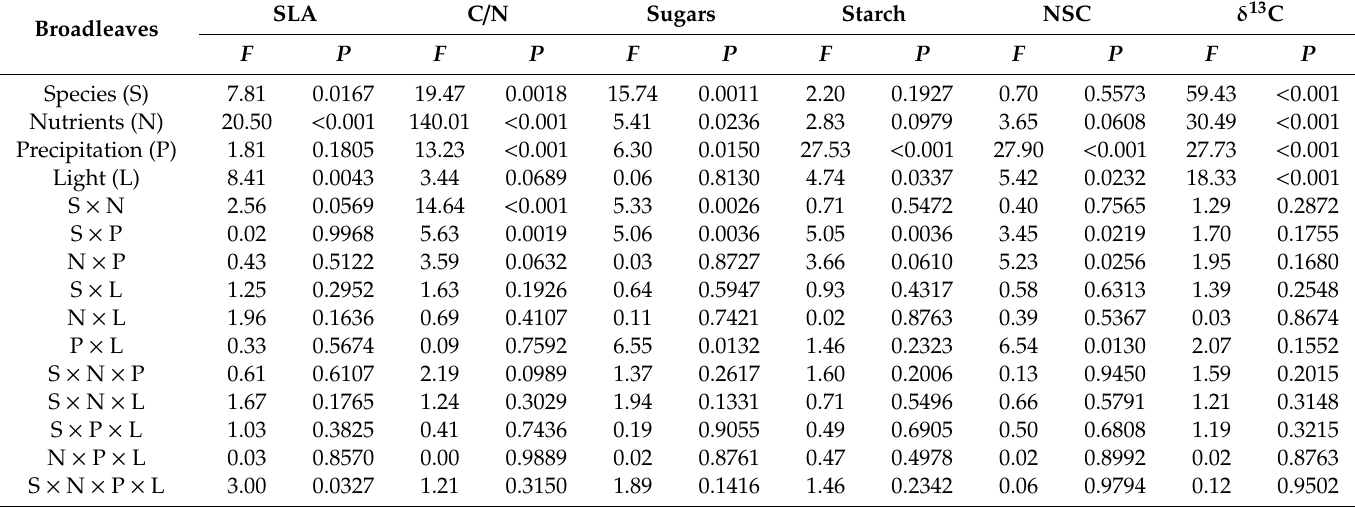
Table 2. Linear mixed model results of the e ff ects of species (S), precipitation (P), shading (L), and nutrients (N) on the specific leaf area (SLA), foliar C / N ratio, foliar soluble sugars concentration foliar starch concentration, foliar total non-structural carbohydrate concentration (NSC) and foliar carbon isotope fractionation ( δ 13C) of deciduous